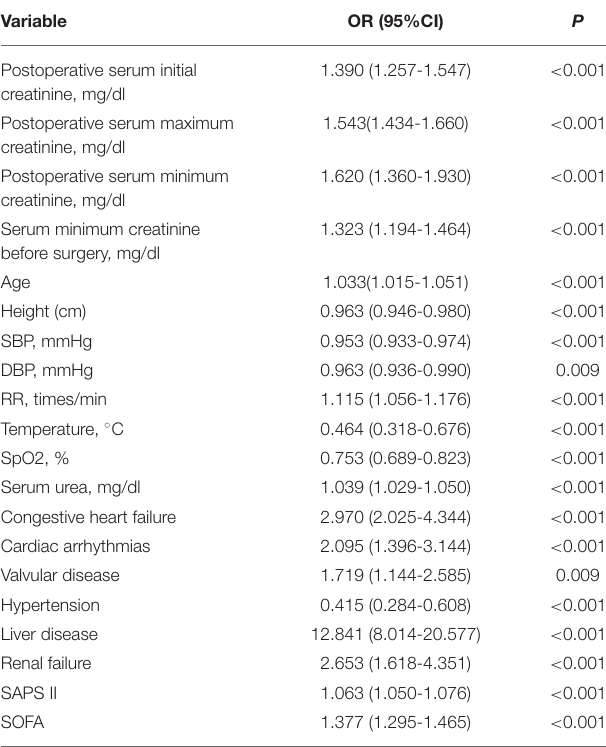
TABLE 4 | Univariable logistic regression analyses for hospital mortality in cardiac surgery